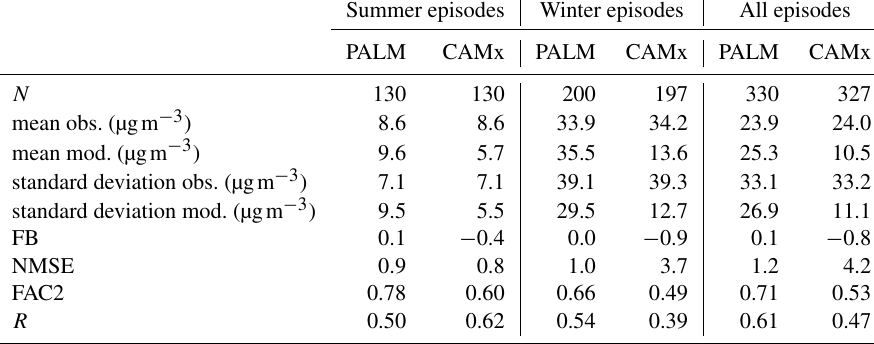
Table 7. Comparison of 1h average NO x concentrations measured in the Sinkule yard with CAMx and PALM results for the same